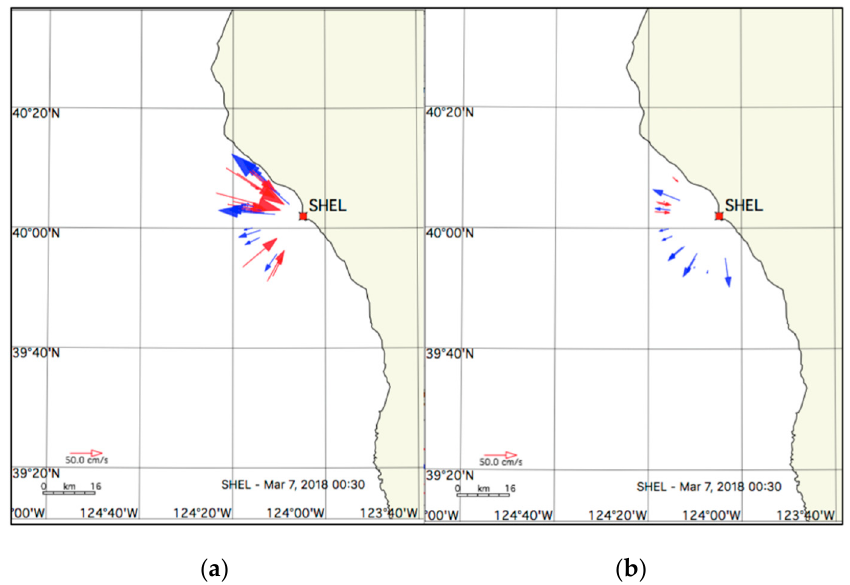
Figure 3. Radial velocities obtained from the radar data 7 March, 2018, 00:30 a.m., range 18 km from ( a ) negative and ( b ) positive Doppler first-order regions. Red/blue radial vectors approach/recede from radar.